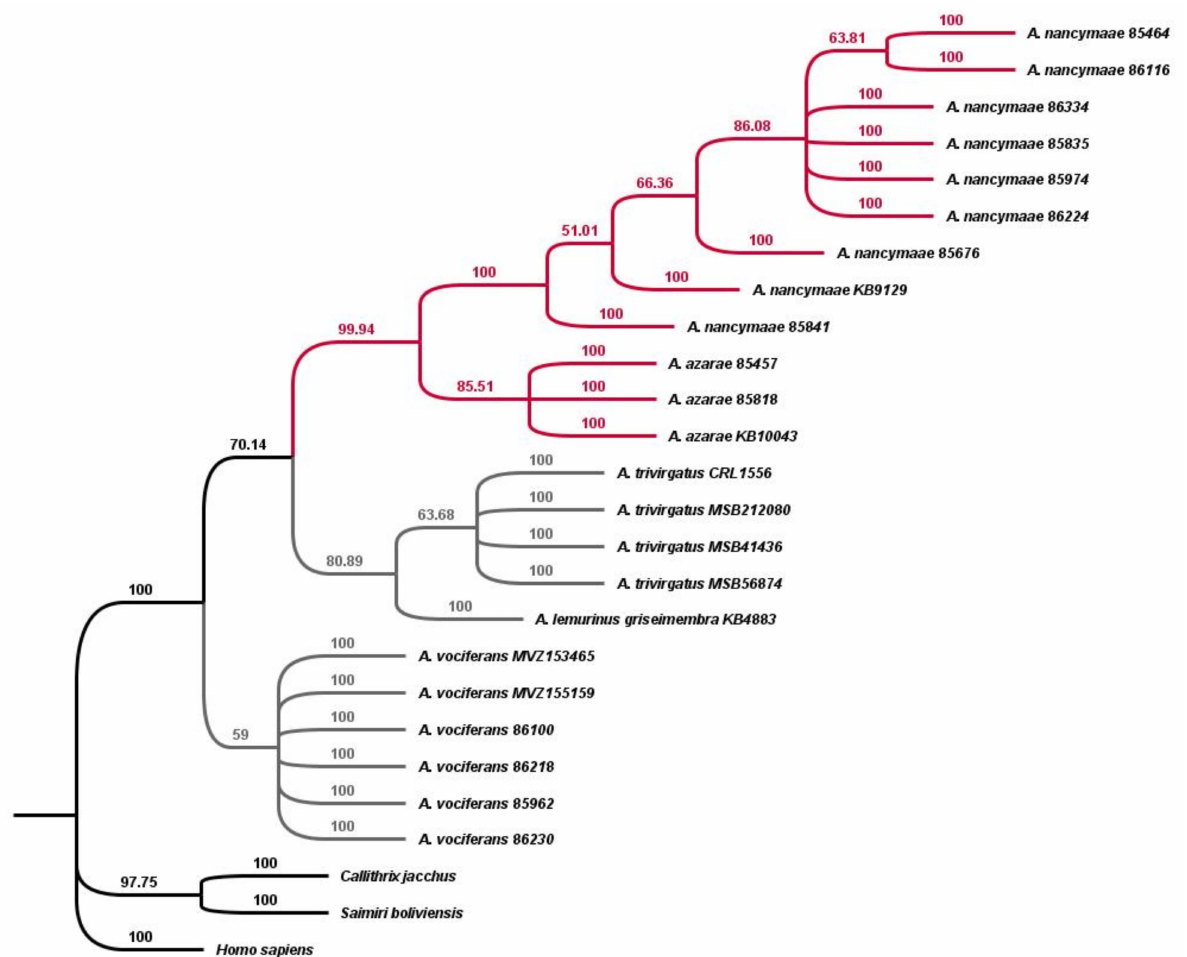
Figure 3. The most parsimonious tree generated from analysis of 314 Alu insertions from the A. nancymaae genome [Anan_2.0]. The amplification patterns and post-sequencing adjustments of the Alu insertions were used to construct a Dollo parsimony tree of phylogenetic relationships with human ( Homo sapiens ), marmoset ( C. jacchus ) and squirrel monkey ( S. boliviensis ) as outgroups using the PAUP* (version 4.0a169) program [56]. Numbers above branches are bootstrap values. Red-necked species A. nancymaae and A. azarae group together (red nodes), while A. vociferans is most basal among grey-necked species (grey nodes) but with low bootstrap support. At the top of the tree, A. nancymaae 85464 and 86116 form a separate branch within the A. nancymaae clade, and they are known to be mother/daughter, respectively. Consistency index (CI): 0.608; homoplasy index (HI): 0.392; retention index (RI): 0.923. The relatively high homoplasy index results from ILS among the grey-necked